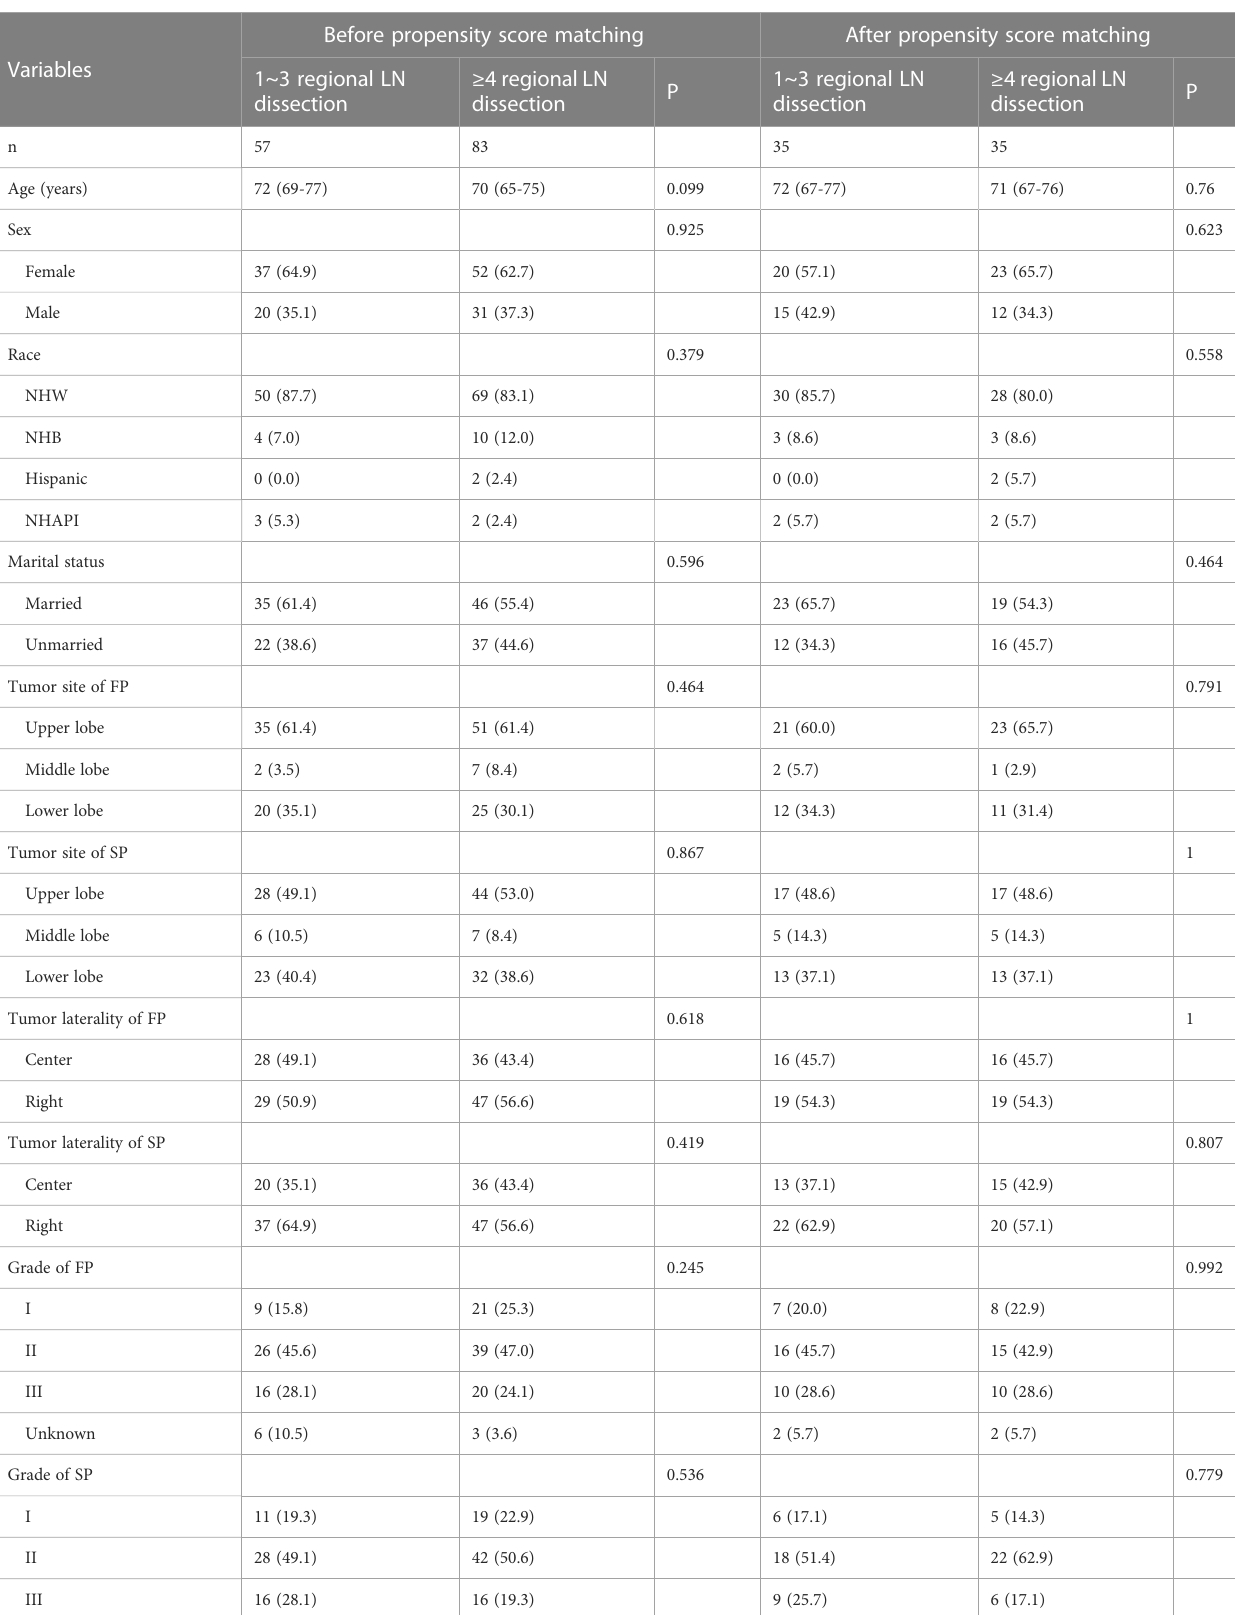
TABLE 3 Baseline characteristics between the stage I SP patients undergoing 1~3 regional LN dissection and patients undergoing ≥ 4 regional LN dissection before and after propensity score matching.